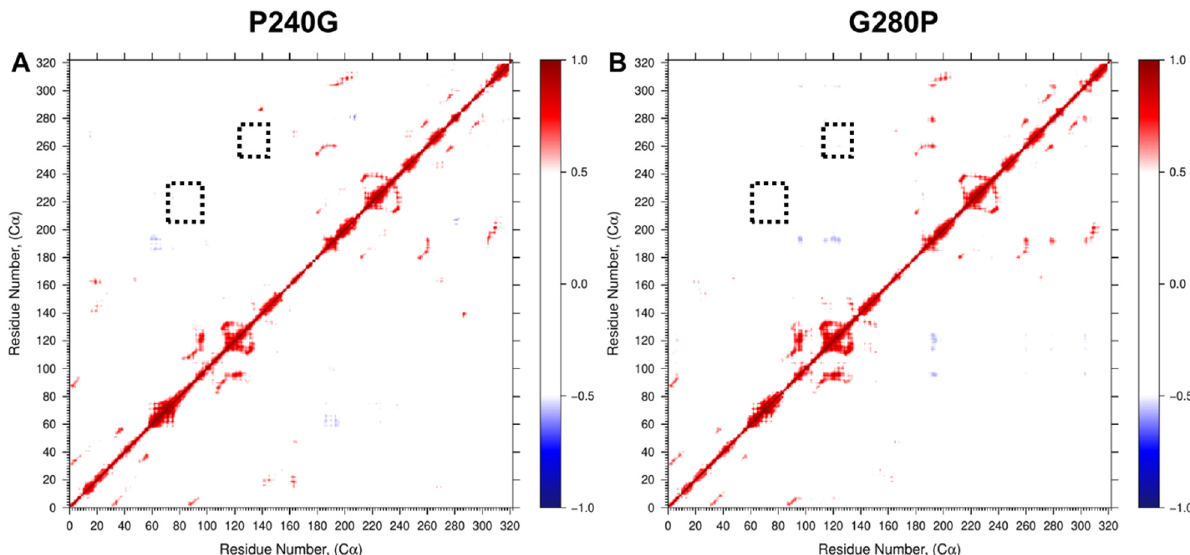
Figure 7. Dynamic cross-correlation (DCC) of residue fluctuation over 0.5 µ s MD simulation of ( A ) P240G and ( B ) G280P HepI mutants showing loss of negatively correlated motion. Dotted black boxes denote 60 and 120 s loop regions identified for mutagenesis.